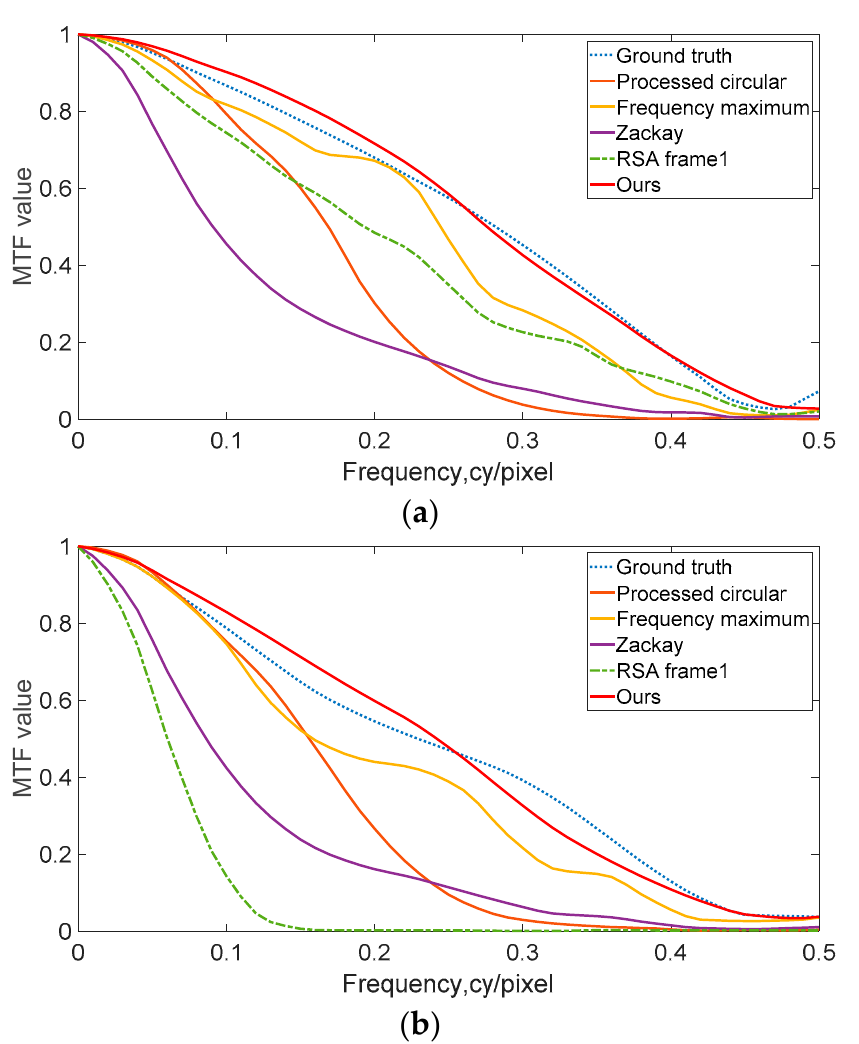
Figure 10. ( a ) The MTF curve of each result and of RRA frame 1 in the horizontal direction. ( b ) The MTF curve of each result and of RRA frame 1 in the vertical direction.